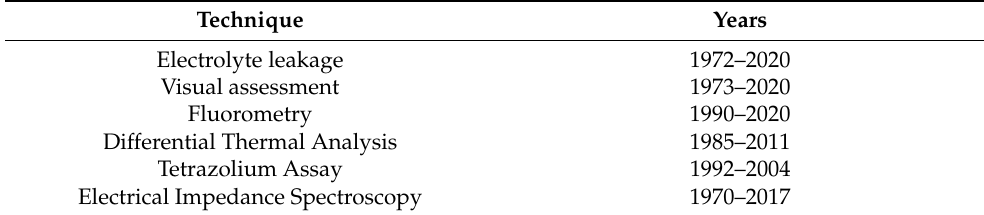
Table 7. Range of years during which each measurement technique was